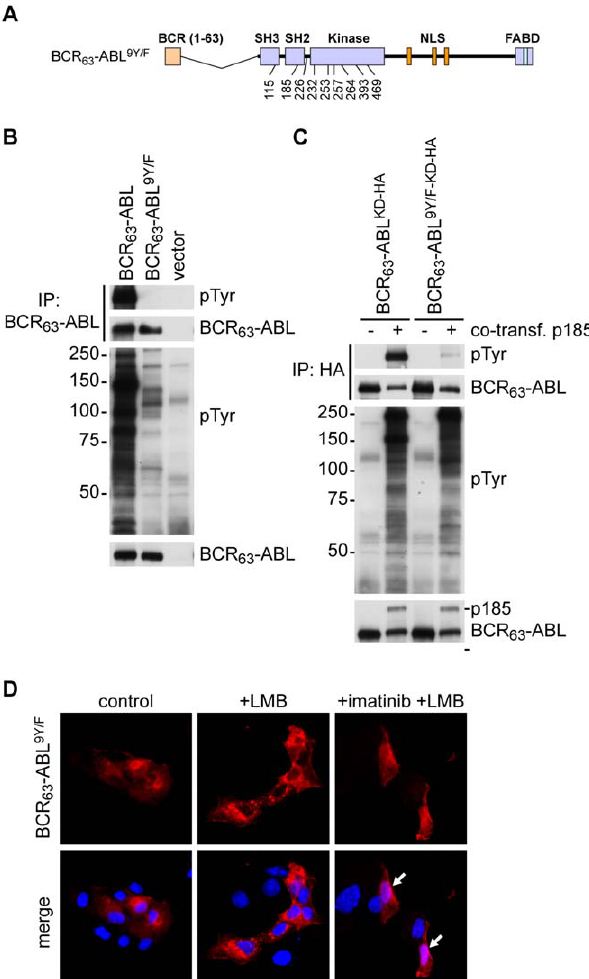
Figure 2. Trans-phosphorylation of kinase-defective BCR-ABL blocks its nuclear import. A : Scheme of experimental design. Kinase- defective BCR 63 -ABL constructs were co-transfected with kinase active p185-BCR-ABLto inducetyrosinephosphorylation of thekinase-defective protein. B : BCR 63 -ABL KD constructs were immunoprecipitated with an anti-HA antibody from COS cells that were co-transfected with the indicated plasmids. Immunoblots from HA-pulldowns (top) and total cell lysates (bottom) were probed with the indicated antibodies to detect the tyrosine phosphorylation of BCR 63 -ABL KD . The previously described b 53- BCR 63 -ABL KD has a beta-turn inserted at position 53, which disables the coiled-coil oligomerization domain [6]. C : COS cells were transfected with the indicated HA-tagged, kinase-defective BCR 63 -ABL KD constructs either alone or in co-transfection with a kinase-active p185-BCR-ABL. The localization of the kinase-defective BCR 63 -ABL proteins was detected by immunostaining with an anti-HA antibody (red). doi:10.1371/journal.pone.0017020.g002 tyrosines (Tyr232, 253 or 257) individually to glutamic acid, which mimics phosphorylation, in the BCR 63 -ABL KD context and found that each Y/E substitution alone is sufficient to block the nuclear import of this kinase-defective BCR 63 -ABL KD protein (Figure 5B). the phosphomimetic mutants Y232E and Y257E (Figure 5B). Y253E mutant (Figure 5B), which is consistent with the fact that BCR-ABL Y253H was an imatinib-resistant mutant isolated from drug-resistant CML cells [35].